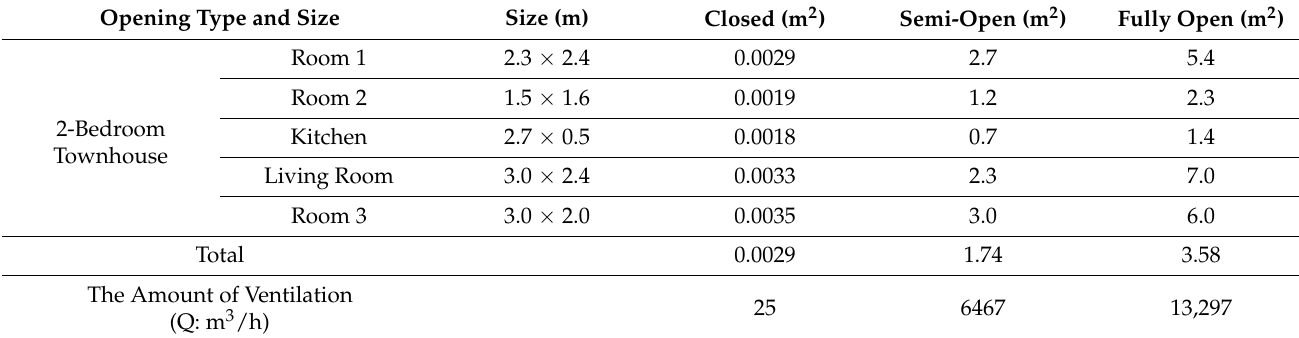
Table 6. The amount of ventilation in a 2-bedroom townhouse.